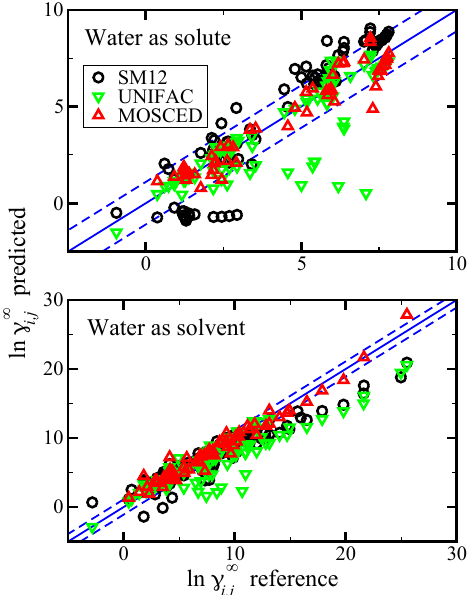
Figure 10. Parity plot of the predicted versus reference values of ln γ ∞ universal solvent model, UNIFAC, and MOSCED versus reference data from “Yaws’ Handbook of Properties for Aqueous Systems” [56]. In the top pane results as shown for the case of water as the solute (water in organics), and in the bottom pane results are shown for the case of water as the solvent (organics in water). The blue lines corresponds to the y = x line, and the dashed blue lines correspond to ± 1.1 and are drawn as a reference. For the SM12 universal solvent model predictions, ∆ G self was i , i